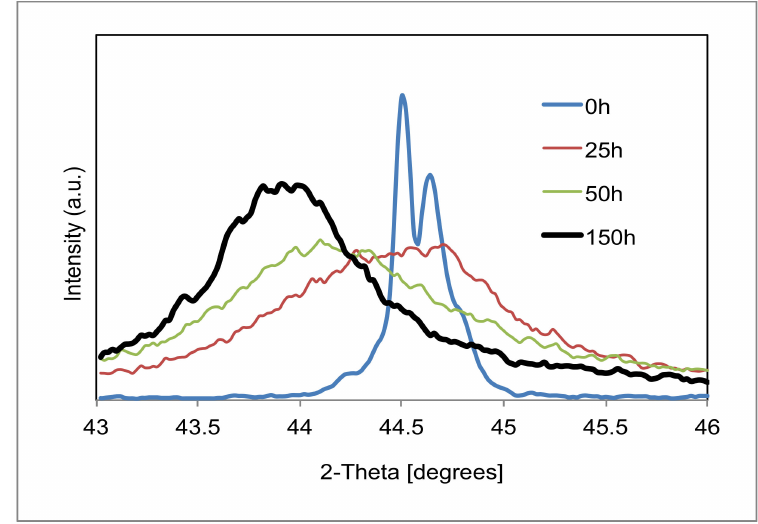
Figure 2. X-ray di ff raction (XRD) patterns of FeCoNiB 0.5 Si 0.5 powders as a function of mechanical alloying time.